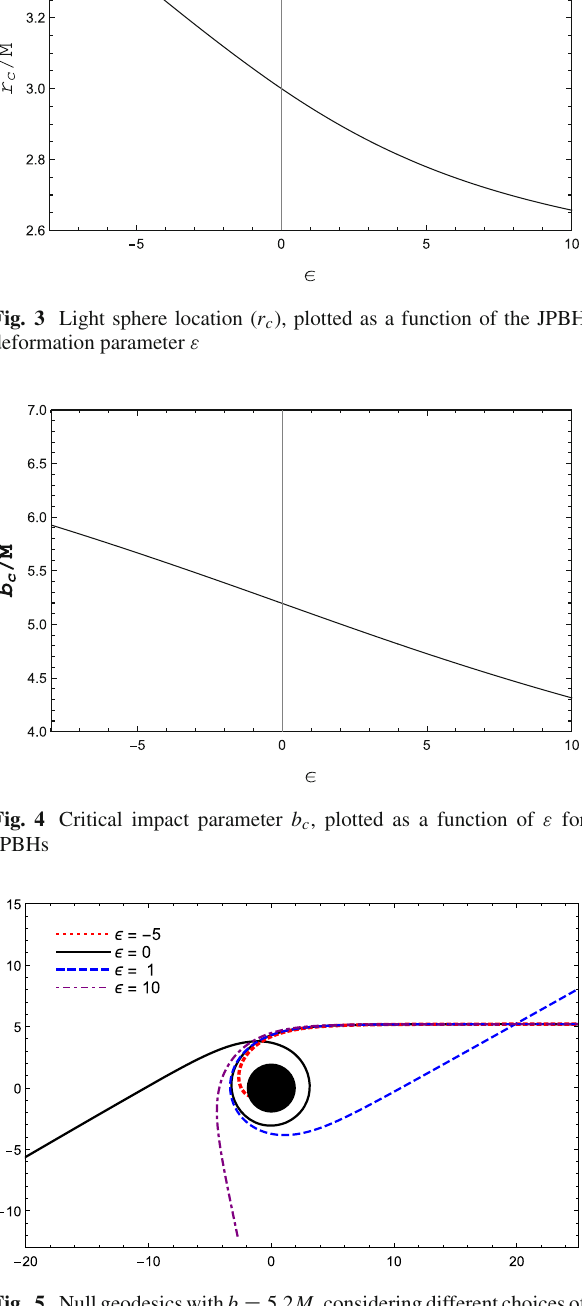
In Fig. 5 we plot the photon trajectories for different choices of the JP parameter ε , fixing the impact parame- ter b = 5 . 2 M . We note that, light rays are less deflected by JPBHs with a bigger deformation